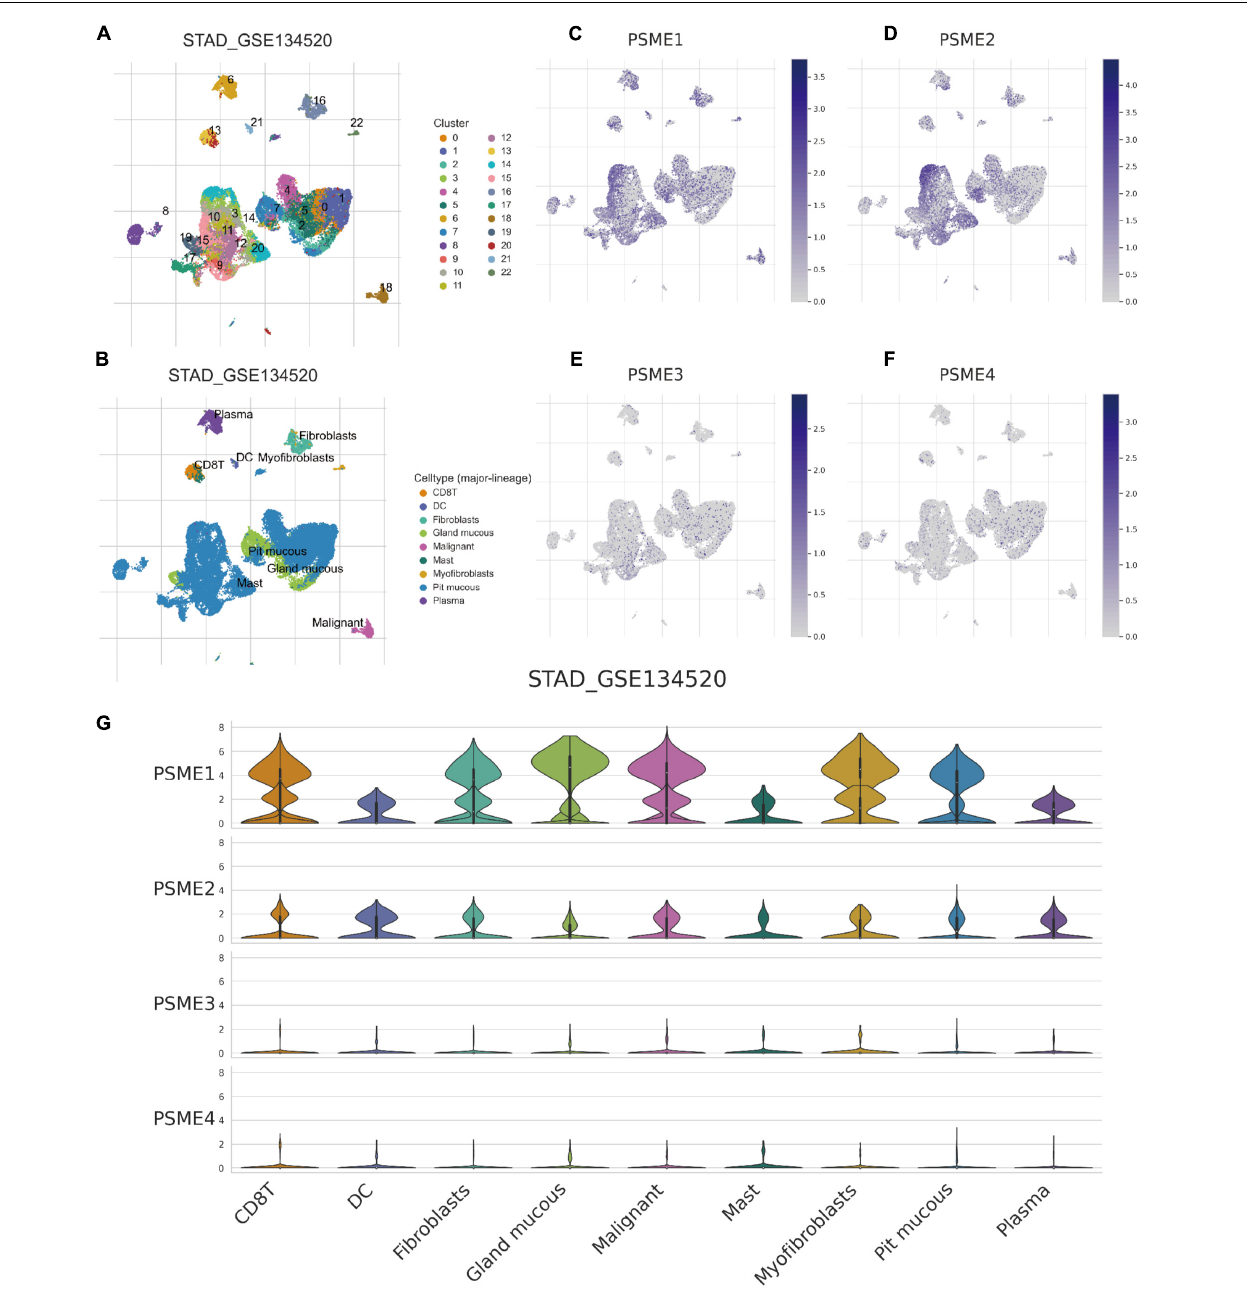
FIGURE 13 | Comparison of PSME family gene expression at single-cell resolution in GC. (A) UMAP visualization of dataset STAD_GSE134520. Colors represent the major-lineage cluster ID. (B) UMAP visualization of dataset STAD_GSE134520. Colors represent the major-lineage cell-types. (C–F) Comparison of PSME gene expression at single-cell resolution in GC. (G) The grid violin plot reflects the distribution of PSME gene expression (LogTPM) in different cell types in